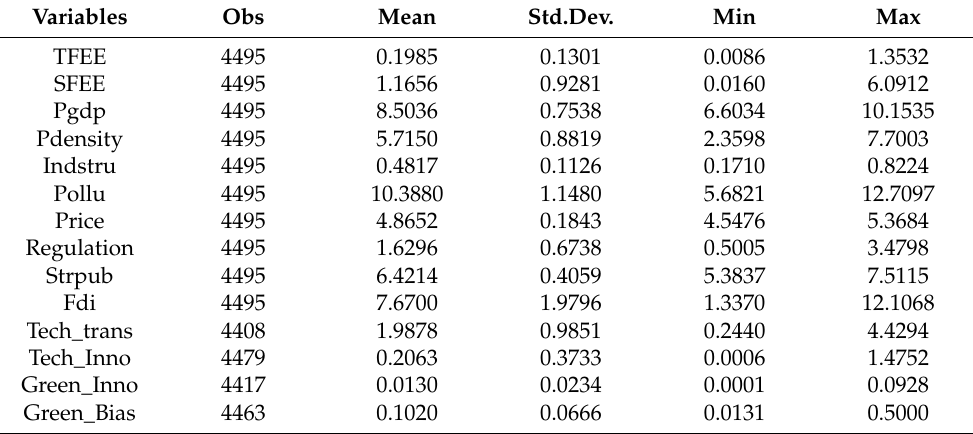
Table 1. Descriptive